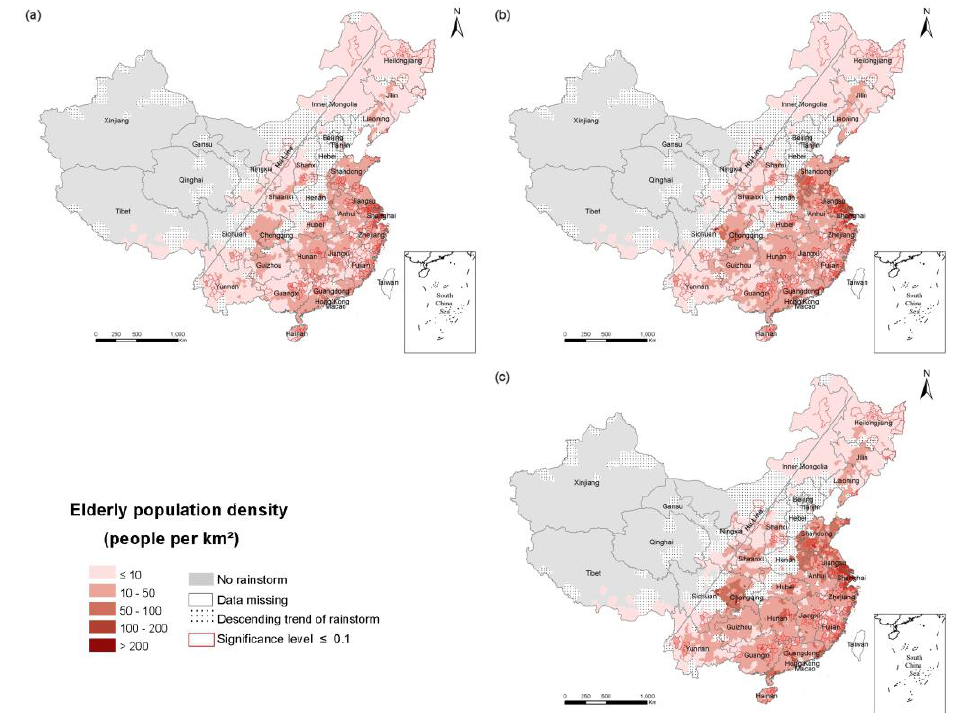
Figure 4. The density of the elderly population in the RSHA. ( a ) 1990; ( b ) 2000; ( c ) 2010. Int. J. Environ. Res. Public Health 2017 , 14 , 963